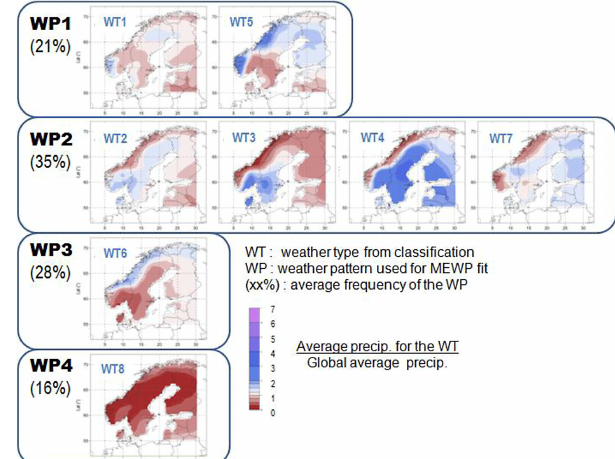
Figure 5. Three weather pattern groups representing seven weather types leading to extreme precipitation and one weather type (WT8/WP4) representing dry